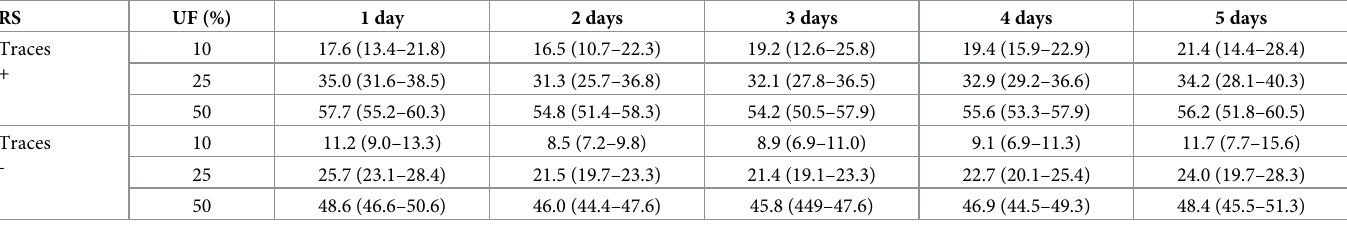
Table 3. Translation of prevalence thresholds from urine filtration (UF) into reagent strip (RS) for the diagnosis of S. haematobium for sampling schemes varying from one to five urine samples over consecutive days when traces were considered either positive or negative. All numerical values are percentages and the brackets contain 95% percentiles from the